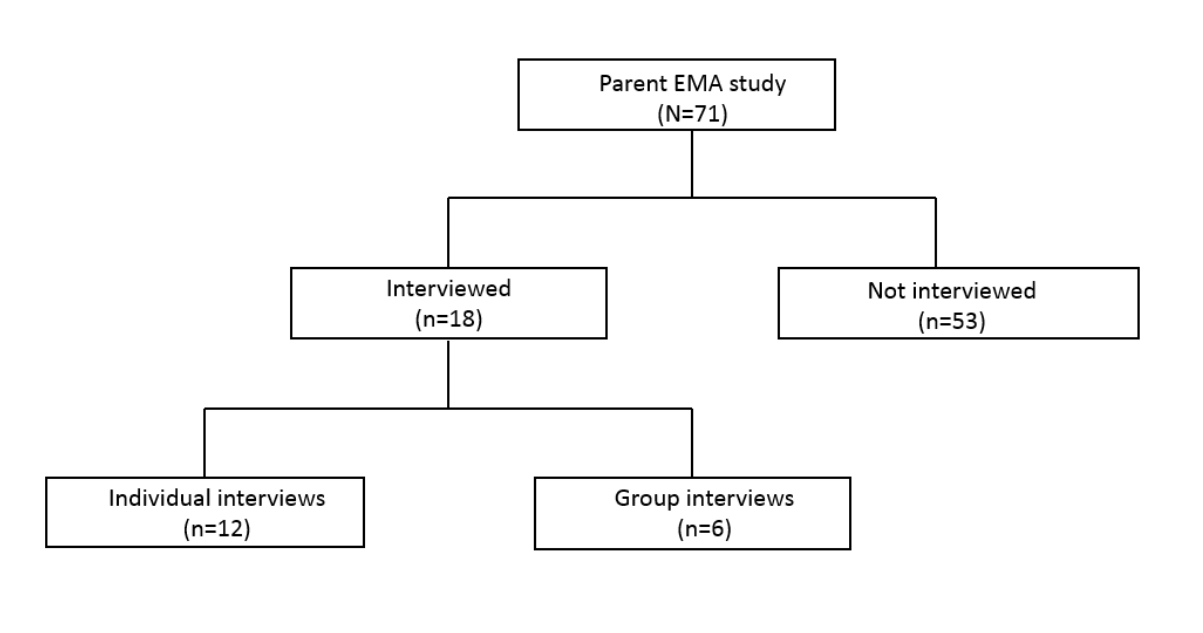
Figure 1. Recruitment. EMA: ecological momentary